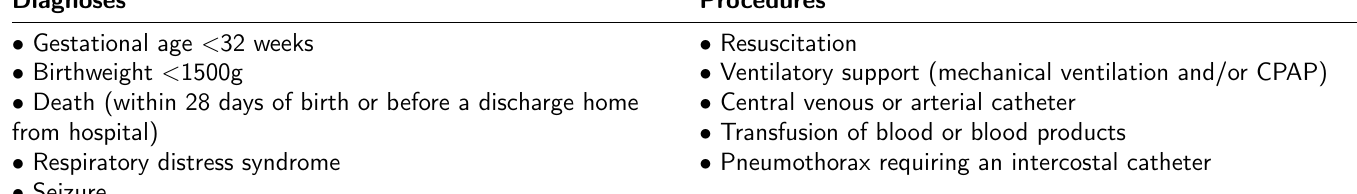
Supplementary table 2: Diagnoses and procedures included in neonatal adverse outcome indicator [33]